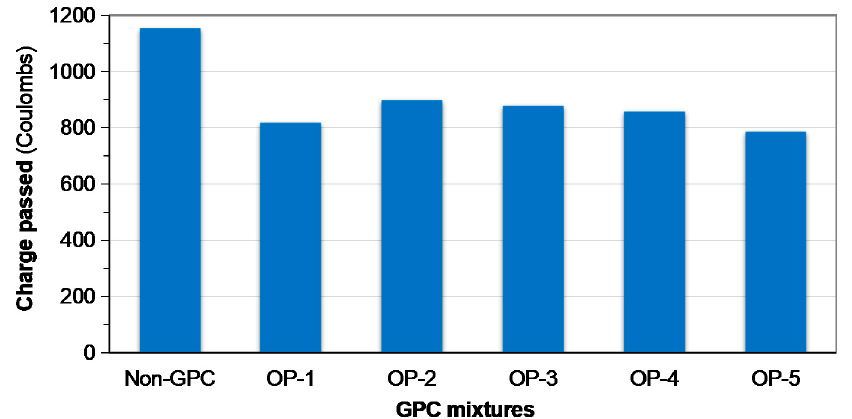
Figure 15. Rapid chloride permeability of coated and uncoated concrete substrate characterized through accelerated charge passed: “Non-GPC” stands for uncoated concrete substrate, and “OP-x” stands for the optimized GPC mixtures listed in Table 3.